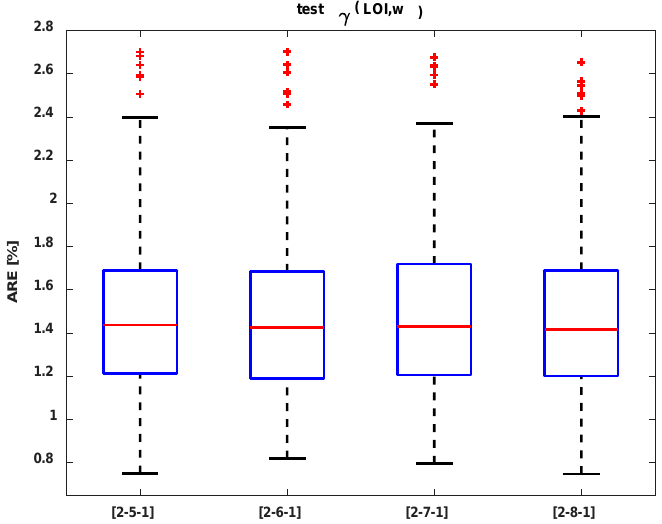
Figure 15. Comparison of the MRE of the nets with two elements in the input vector.